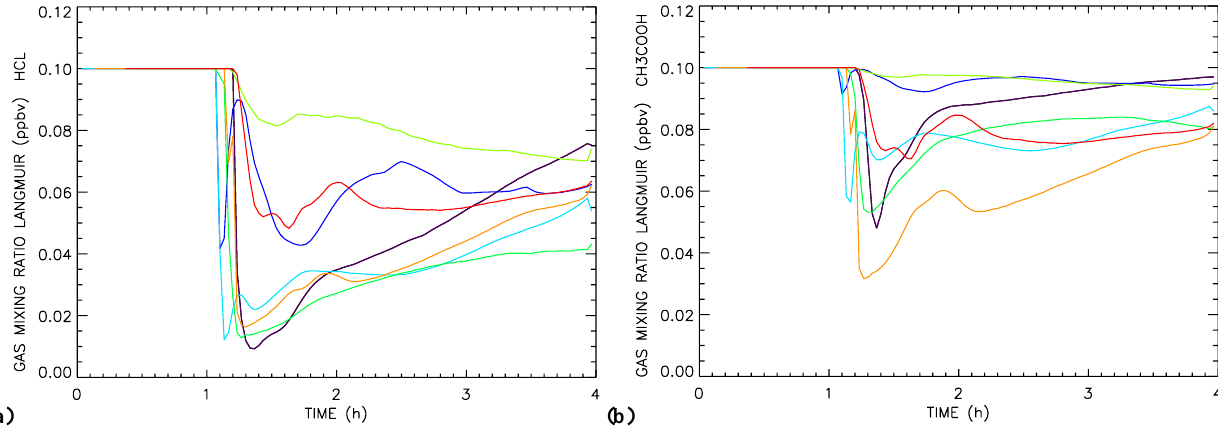
Fig. 9. Results of the Langmuir approach. (a) HCl gas mixing ratio versus time with an initial mixing ratio of 0.1ppbv, (b) CH 3 C(O)OH gas mixing ratio versus time with an initial mixing ratio of 0.1ppbv, along the selected trajectories from the REF simulation.